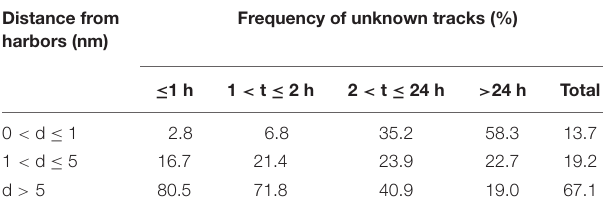
TABLE 1 | Frequency of unknown tracks (%) in terms of duration (t) and distance (d) from harbors. Distance from harbors